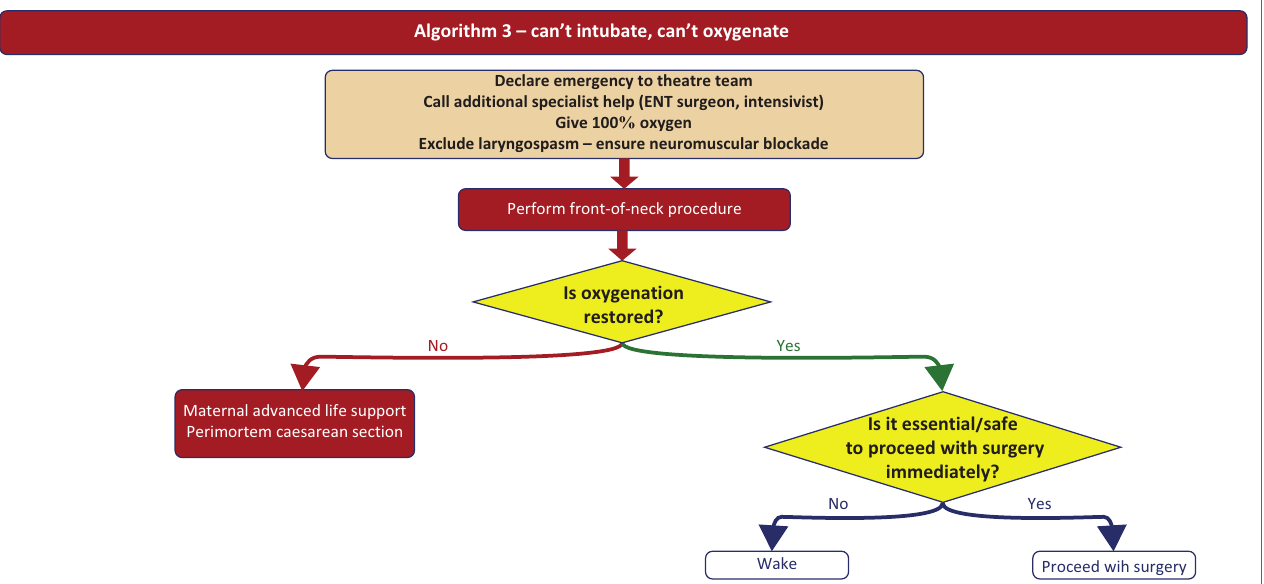
Algorithm 3 – can’t intubate, can’t oxygenate